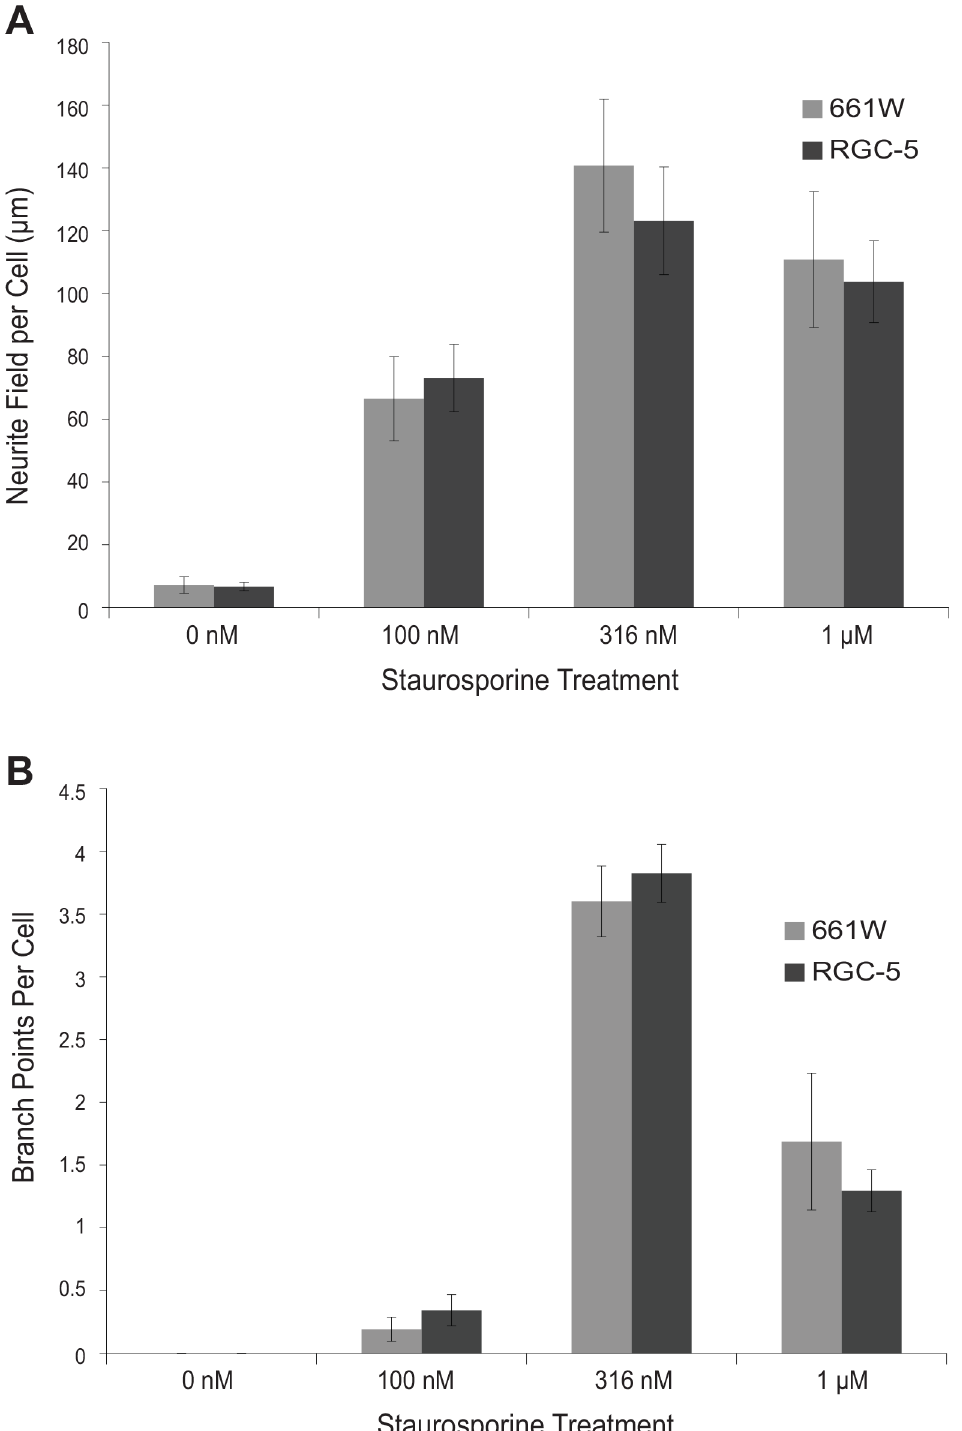
Fig 2. 661W and RGC-5 cells differentiated with staurosporine have similar total neurite lengths and numbers of neurite branch points. Cells were incubated in the indicated concentrations of staurosporine for 24 hr, fixed, photographed, and neurites traced with NeuronJ. (A) Mean ± SEM of the total neurite length per cell. (B) Mean ± SEM of the number of neurite branch points per cell. Comparisons between 661W and RGC-5 were not significantly different at every concentration studied.